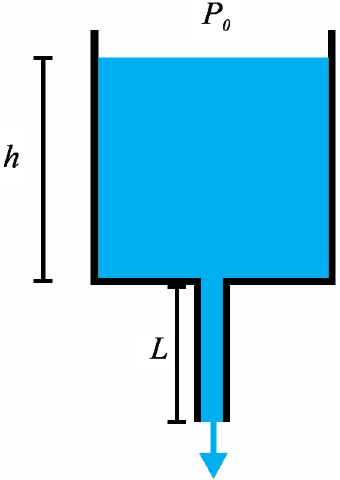
FIG. 5. Same setup as in Fig. 4 but in this situation two ends are blocked.